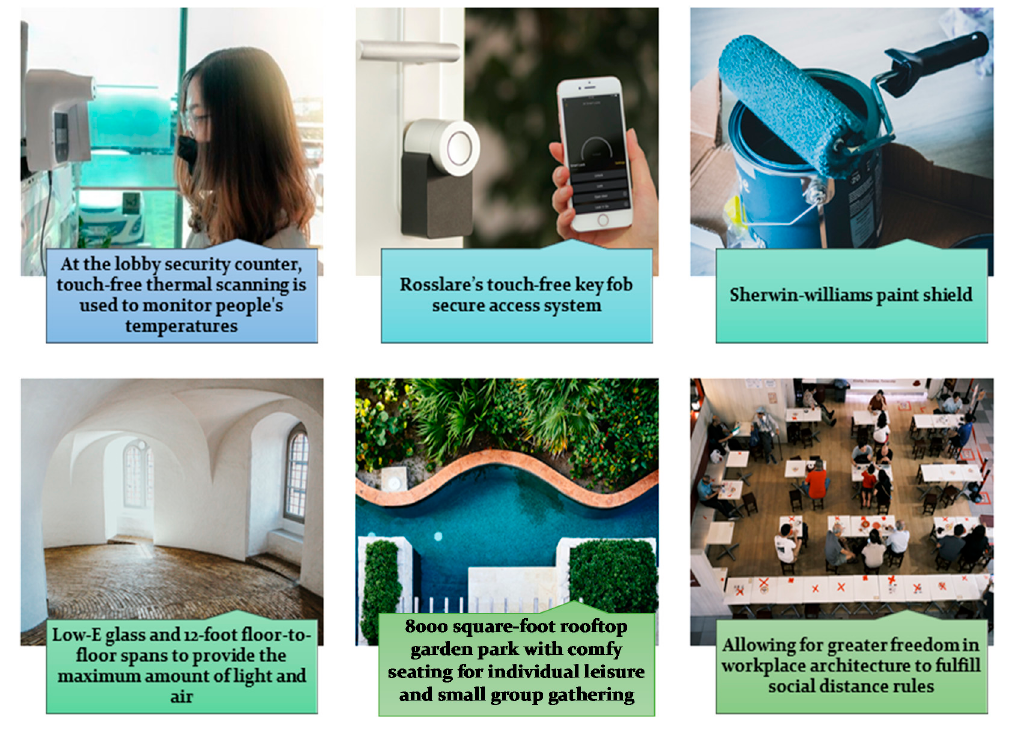
Figure 5. The techniques used to reduce the environmental risks for airborne transmission in Fulton East building [37,38] (photos: reproduced with permission under the terms of the Creative Commons CC0 license. 2021, published on Pexels website).